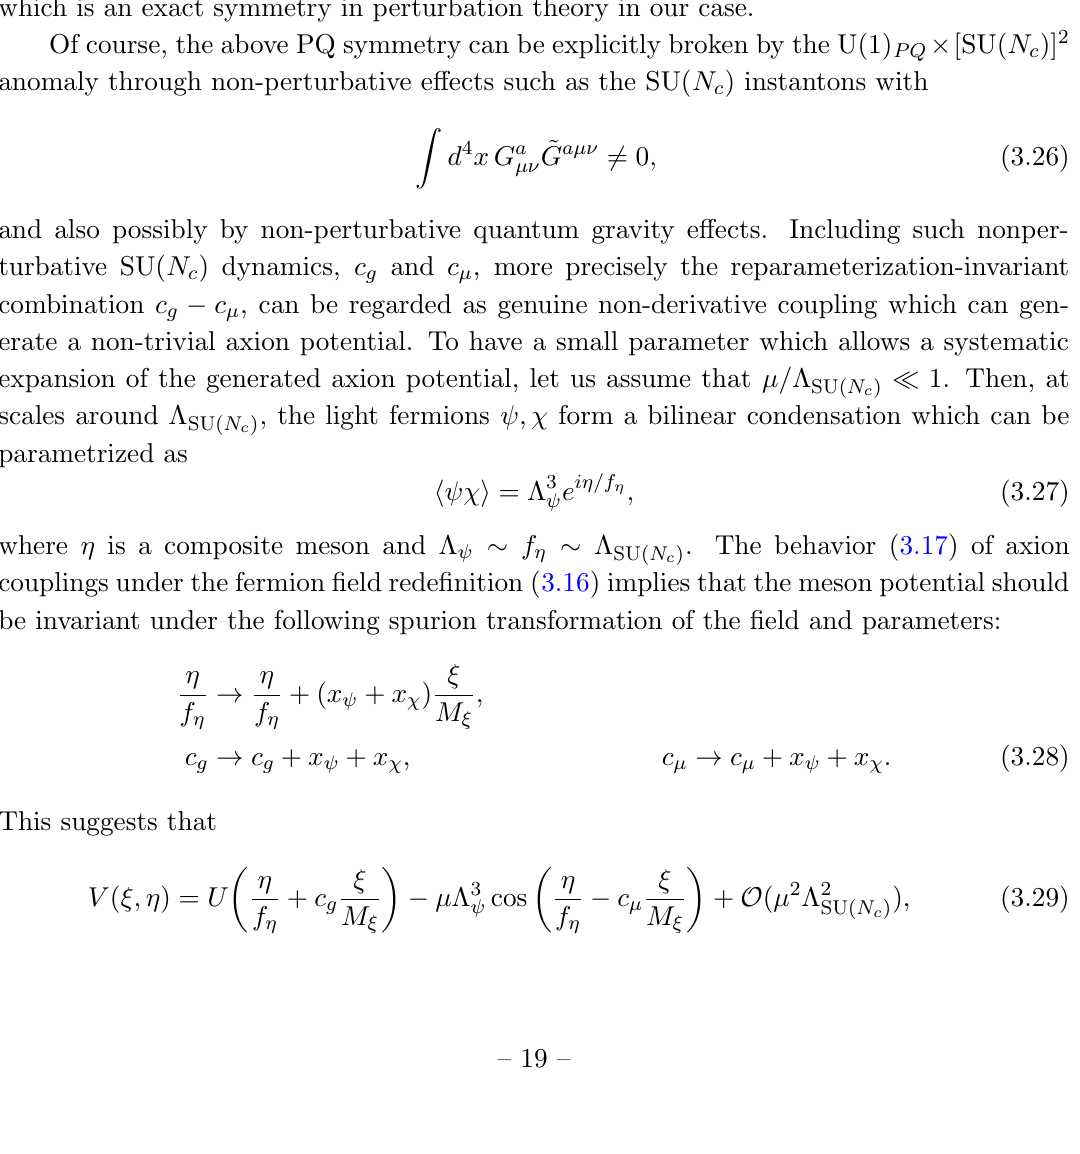
or the non-derivative coupling c (cid:22) i